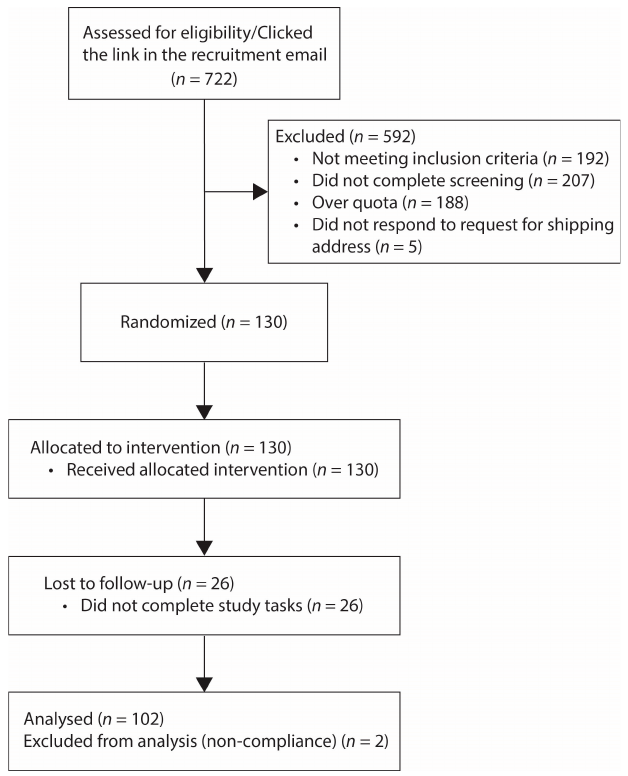
Figure 2. CONSORT flow diagram. Table 1. Characteristics of participants.